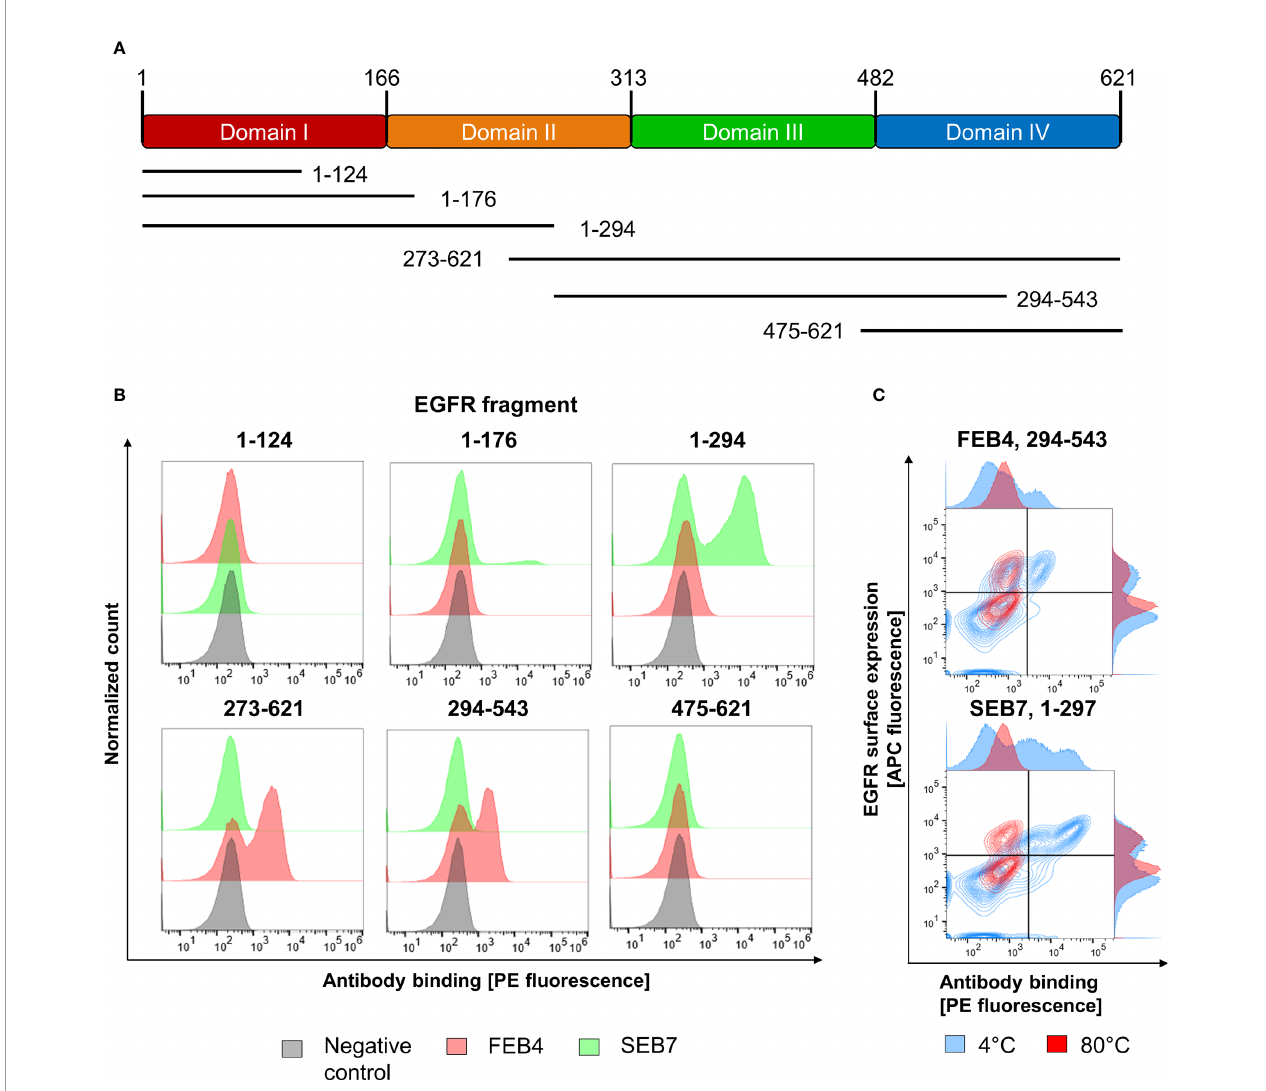
FIGURE 3 | Epitope analysis of FEB4 and SEB7. (A) Schematic representation of EGFR domains and the fragments investigated in this study. (B) YSD-based epitope mapping. Binding of FEB4 and SEB7 to yeast cells expressing different EGFR-derived domains were detected utilizing the goat anti-human Fc PE antibody. (C) Conformational epitope recognition on various truncated versions of EGFR-ECD. Yeast cells expressing the targeted EGFR-derived fragments were either incubated at 4°C or 80°C, respectively, for 30 min. Surface presentation was veri fi ed by the anti-c-myc biotin antibody and Streptavidin APC, binding of FEB4 and SEB7 was measured utilizing the anti-human Fc PE